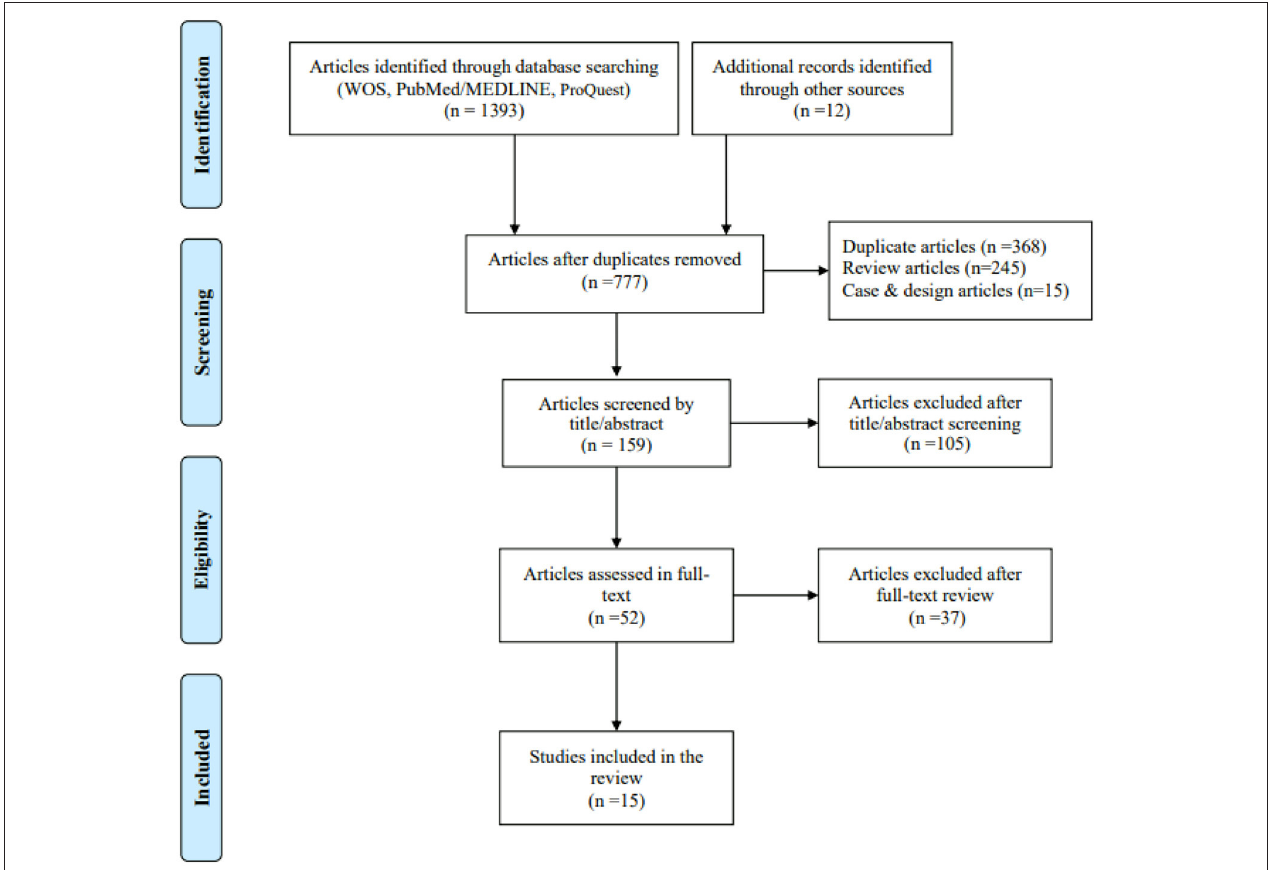
FIGURE 1 | Flow diagram for evidence source search. From: Moher et al.